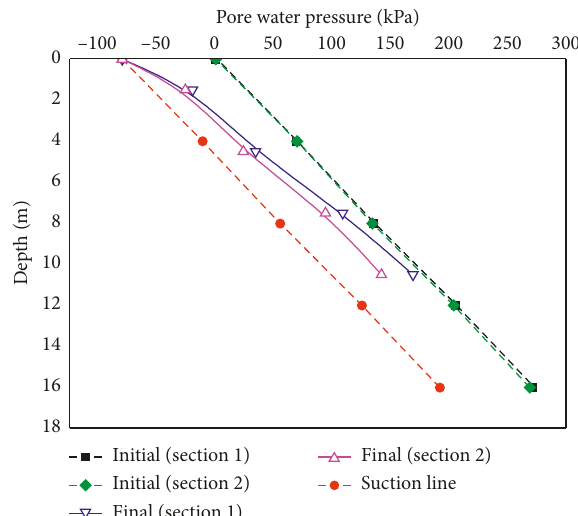
Figure 16: Pore water pressure profiles obtained for sections 1 and